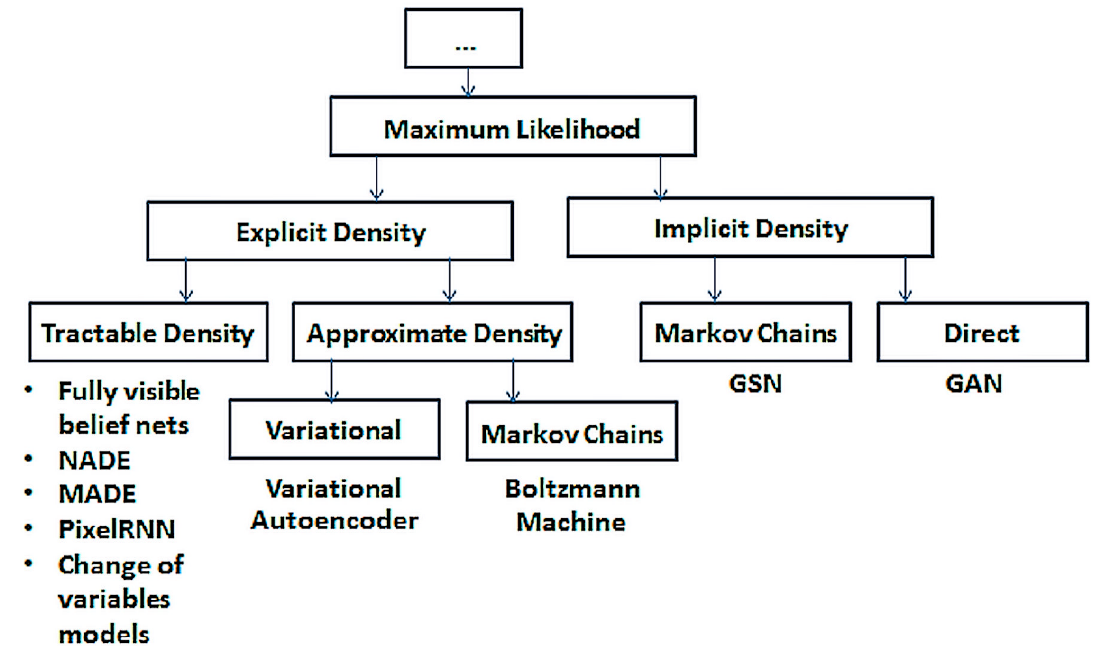
Figure 1. Taxonomy of deep generative models.